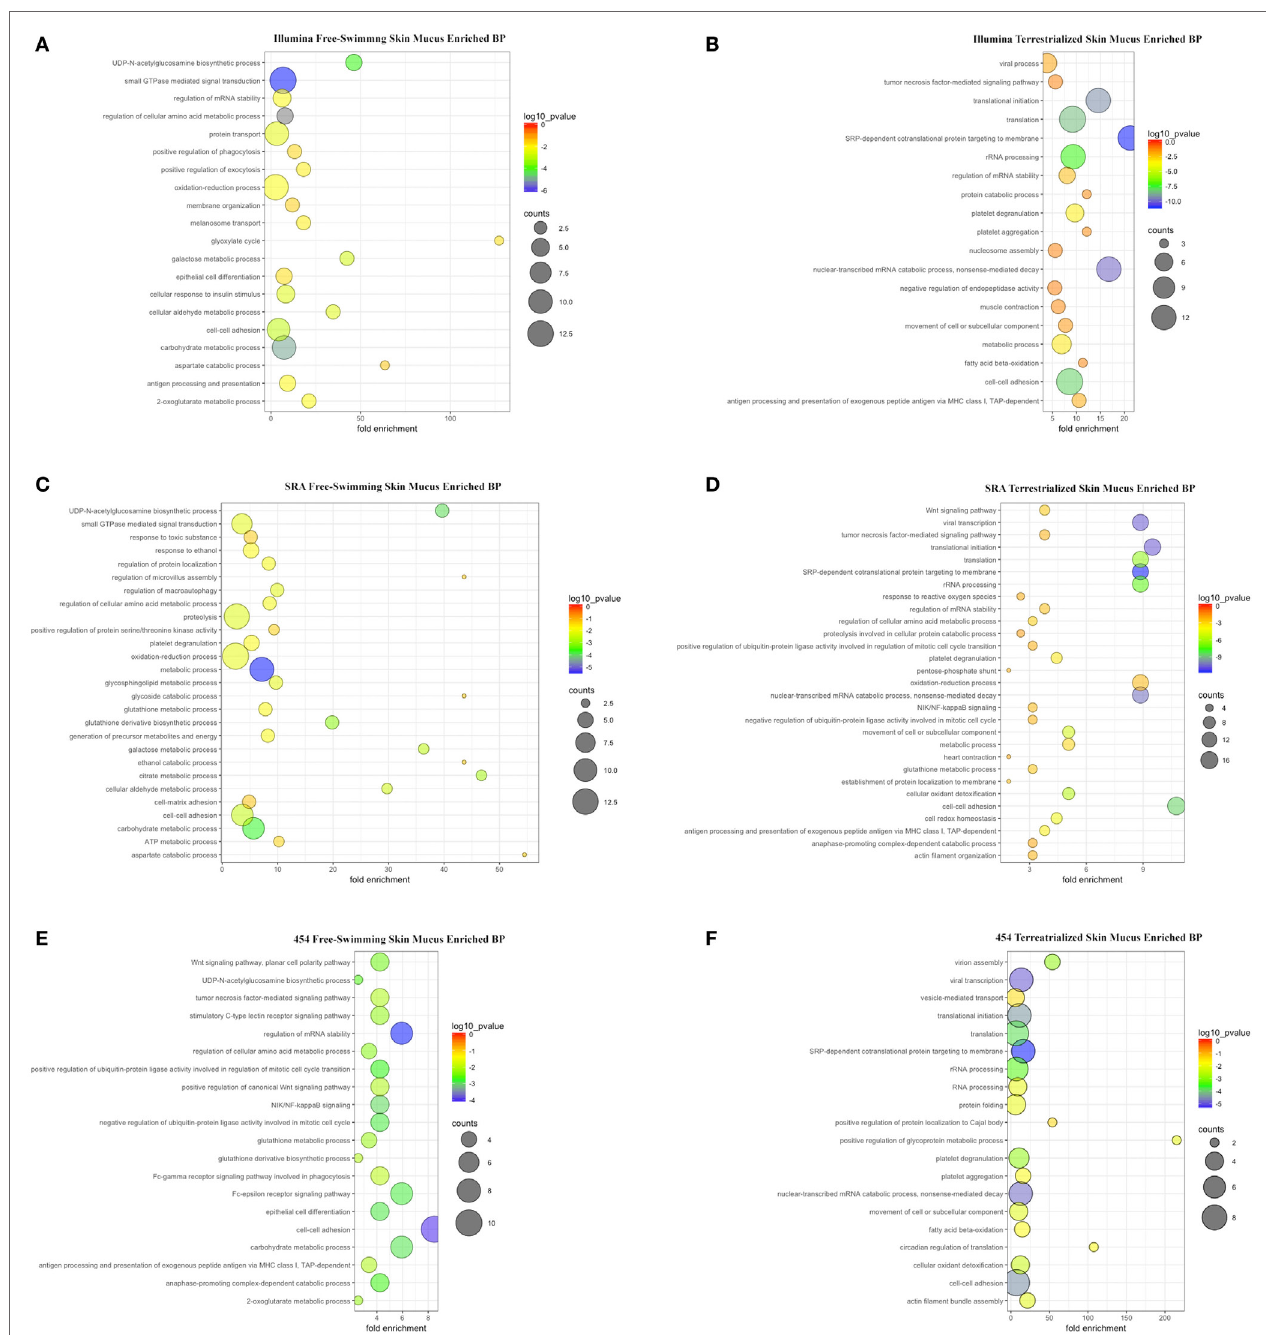
FigUre 4 | Scatter plots of enriched gene ontology biological process (BP) terms for (a) free-swimming skin mucus and (b) terrestrialized skin mucus using the Illumina database; for (c) free-swimming skin mucus and (D) terrestrialized skin mucus using the sequence read archive (SRA) database; and for (e) free-swimming skin mucus and (F) terrestrialized skin mucus using the 454 database. The fold enrichment indicates the ratio of the expressed gene number to the total gene number in a pathway. Only the top 20 BPs according to p -value are shown. The size and color of the points represent the gene number and the log10 p -value of each pathway,